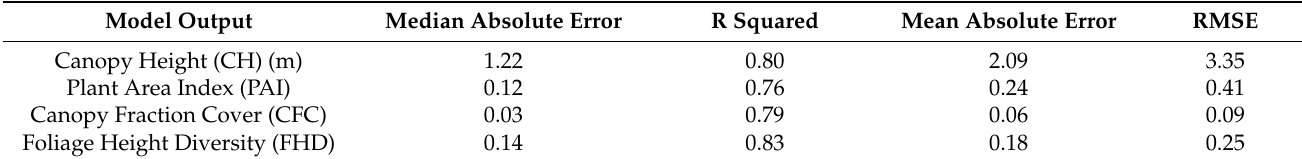
Table 5. Random Forest Regression models performance metrics calculated using set-aside validation samples. Model Output Median Absolute Error R Squared Canopy Height (CH) (m) Plant Area Index (PAI) Canopy Fraction Cover